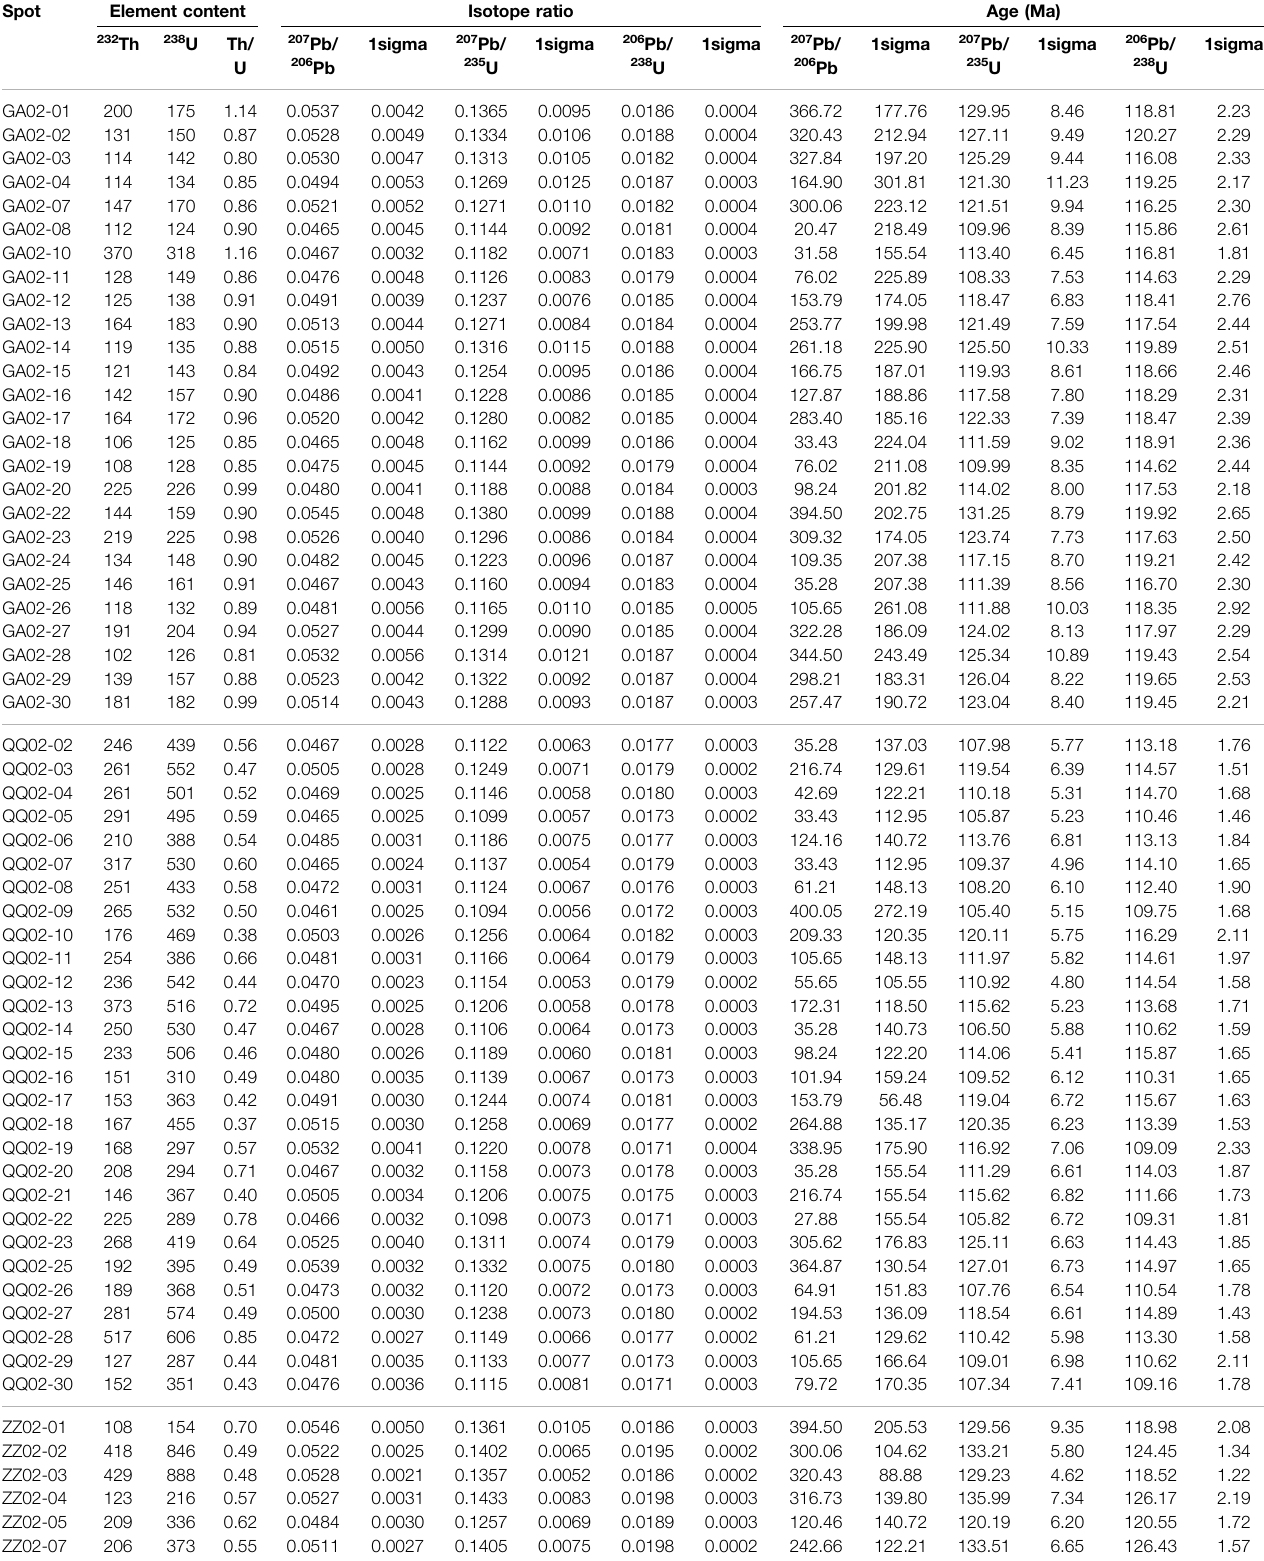
TABLE 1 | Zircon U-Pb data of granites in the study